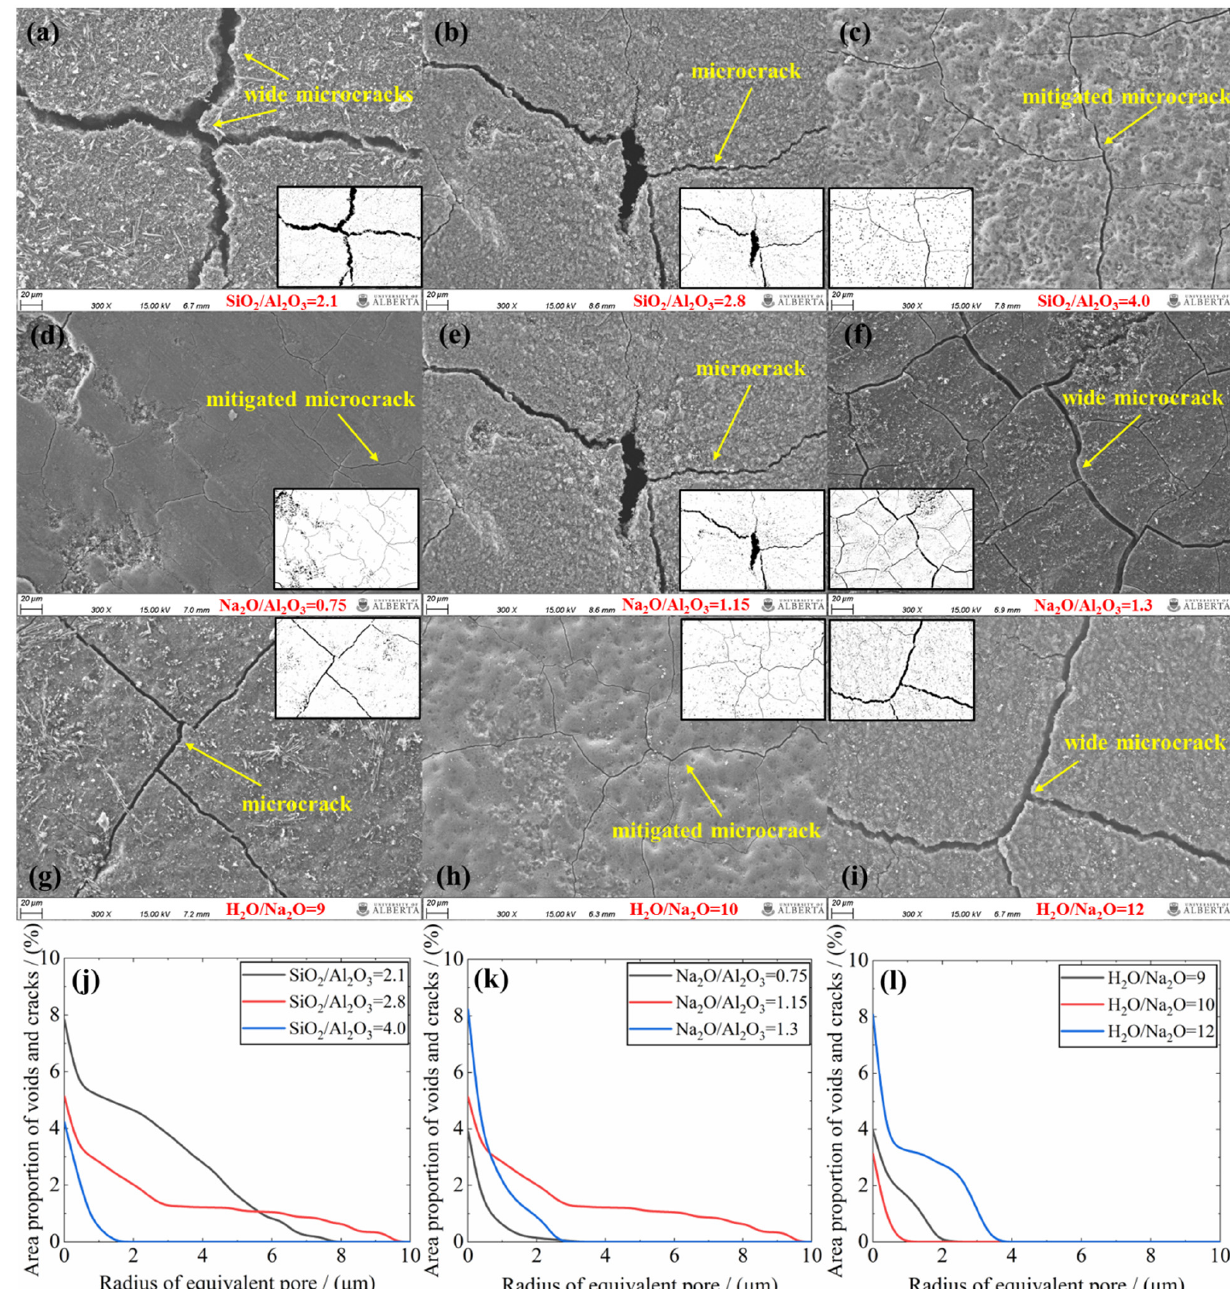
Figure 9. SEM images of geopolymer mixture made with varying ( a – c ) SiO 2 /Al 2 O 3 , ( d – f ) Na 2 O/Al 2 O 3 ( g – i ) H 2 O/Na 2 O and ( j – l ), their quantified voids and